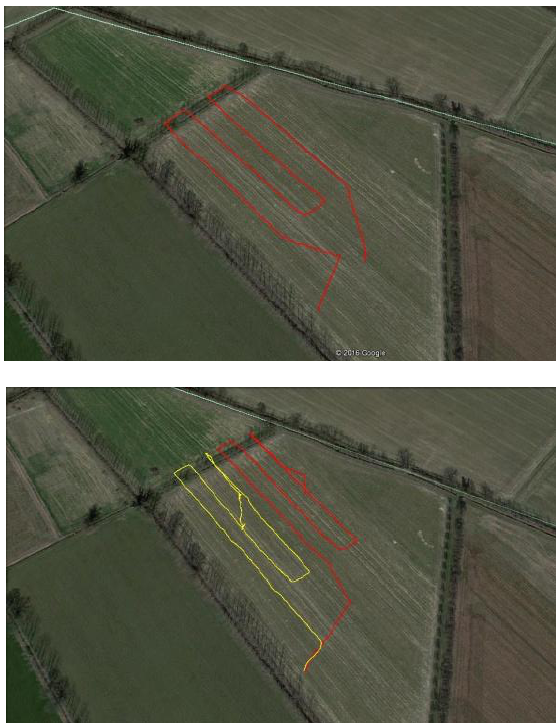
Figure 1. The flight paths: RGB (above), NIR-RG (below). The photogrammetric block relative to the June flights was georeferenced with only 13 GCP. The targets were located on poles 2.5m high and the RTK-GNSS survey was realized on the side of the markers. For this reason the GCPs accuracy was about 30 cm.